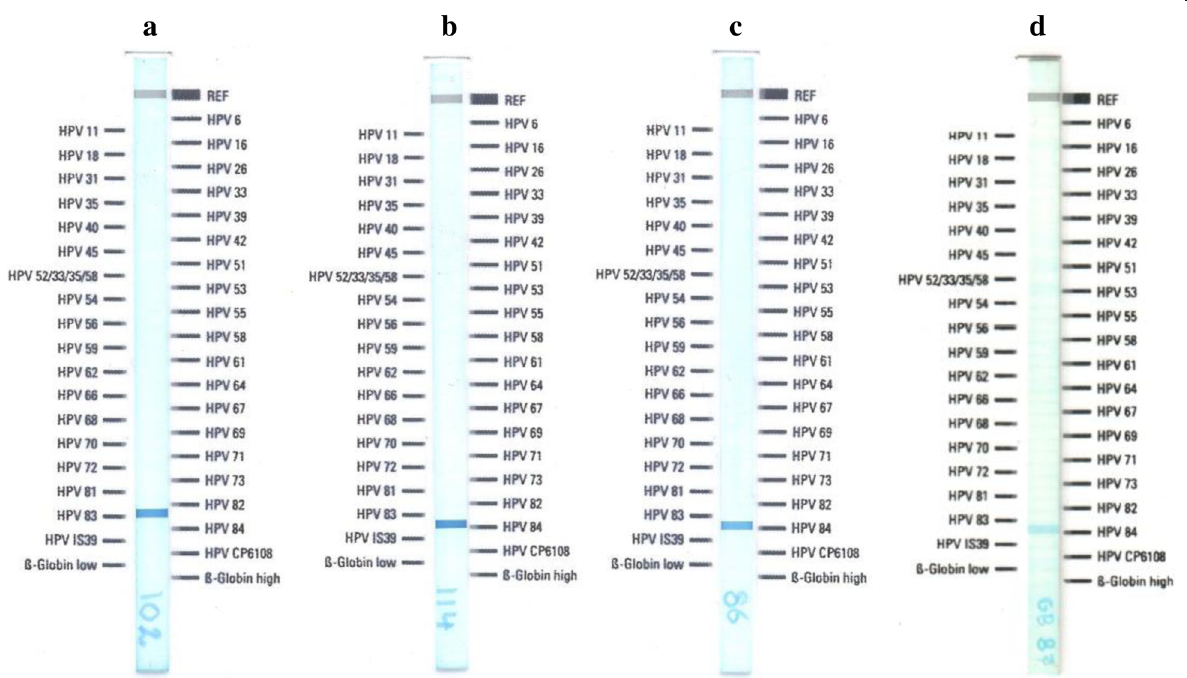
Fig. 1 Linear array Genotyping test performed individually with different L1 gBlocks (double stranded genomic blocks). The gBlocks were designed from HPV genotypes 102 ( a ), 114 ( b ), 86 ( c ) and 87 ( d ) and taken as template for the LA